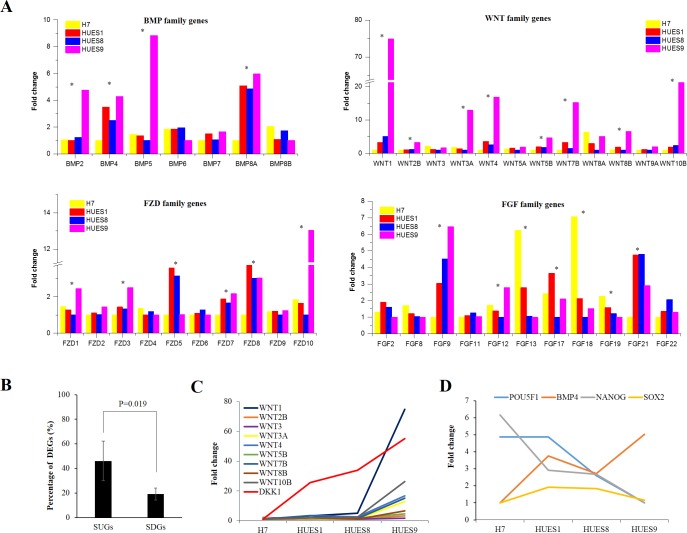
Expression variations of genes involved in IGF/PI3K, FGFMAPK, TGF-β and Wnt signaling pathways in hESC lines H7, HUES1, HUES8 and HUES9.(A) Fold change of BMP, WNT, FDZ and FGF family genes among the four lines. * represents genes differentially expressed at least between two cell lines by FC > 2 and FDR < 0.01. (B) Percentage of DEGs in PUGs and PDGs of the four signaling pathways. Statistically significant were analyzed by student's t-test. (C) Line chart showing fold change of differentially expressed WNT family genes and inhibitor DKK1 in Wnt signaling pathway in the four cell lines. (D) Line chart depicting fold change of BMP4 and pluripotent factors POU5F1 and NANOG in the four cell lines. Fold change of each gene mentioned here was normalized by the minimum CPM of the gene among the four lines.